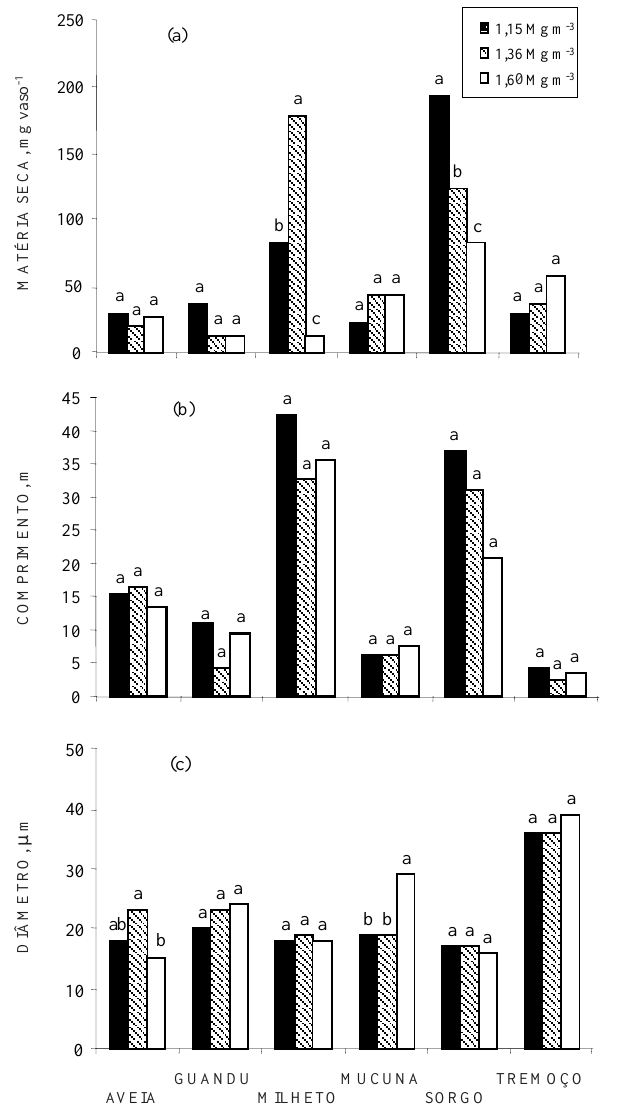
Figura 3. Produção de matéria seca (a), comprimento (b) e diâmetro (c) das raízes na profundidade de 18,5-33,5 cm, considerando as densidades do solo impostas na profundidade de 15-18,5 cm.